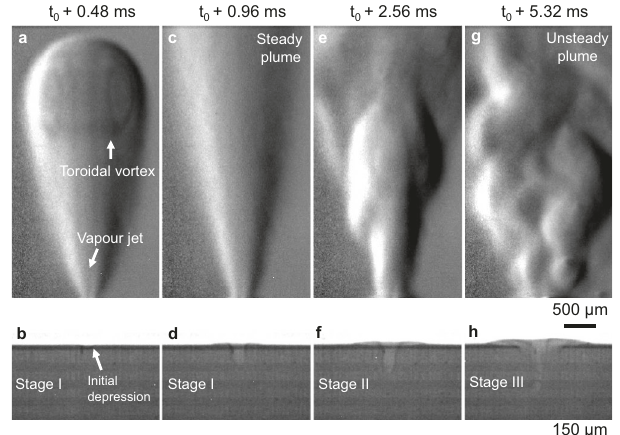
Fig. 2 Time evolution of depression and plume under a stationary laser spot of power P = 72 W and 1/ e 2 diameter d = 84 µ m, corresponding to a power density of Φ = 4 P/ π d 2 = 1.3 MW cm − 2 for substrate only (no powder). a Initial plume front propagating upwards in Ar atmosphere due to vapour jet. Metallic fumes follow the fl ow ’ s streamlines, outlining a vortex structure at the tip of the plume. b Initial depression (depth ~ 5 μ m). c Expansion of the evaporated species leads to a steady atmospheric fl ow. d Depression depth steadily increases (depth ~ 25 μ m). e The momentum driving the fl ow changes direction according to the motion of the vapour jet, intermittently disrupting fl ow stability. f The depression expands rapidly, while the previous hemispherical shape is maintained (depth ~ 120 μ m). g Chaotic plume comprised of several eddies formed by constant fl uctuation of the LVI. h Fully evolved keyhole, driven by the interplay between recoil pressure and capillary instability. 500 μ m scale bar applies to ( a , c , e , g ), 150 μ m scale bar applies to ( b , d , f , h ). A video with the images used in this fi gure is available in the supplementary